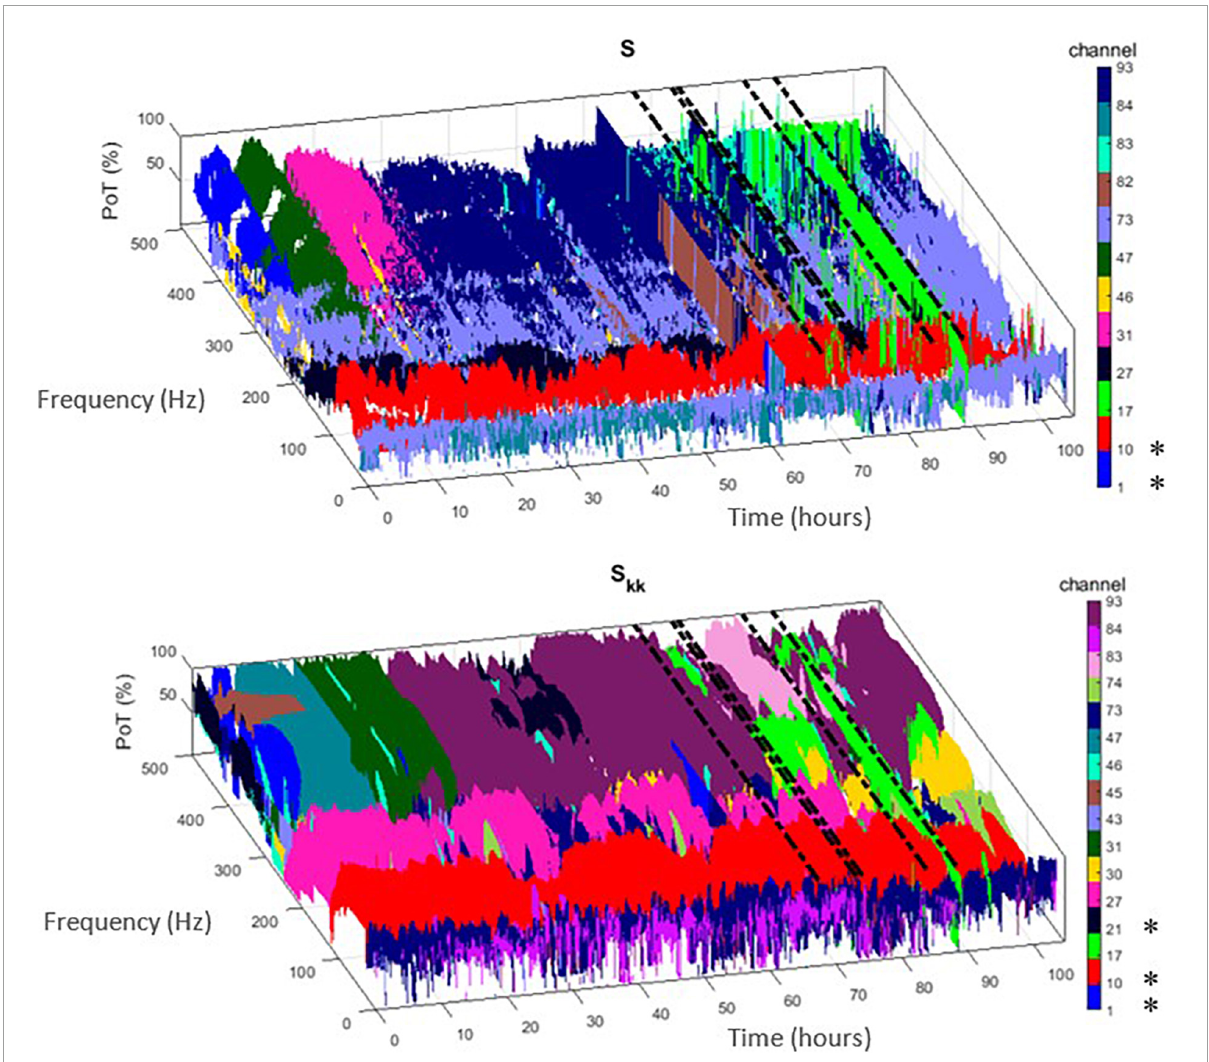
FIGURE1 Time-frequency plots of the highest percentage of time (PoT) channels that exhibited maximum power within the non-overlapping 10 min window from the two proposed measures [i.e., periodogram ( S ) – (top) and auto-spectra ( S kk ) – (bottom) ]. Each channel is denoted with a different color. If this methodology selected clinically assessed focal channels for patient PT103, we denote them by ( ∗ ) in the colorbar. Dashed black lines indicate the timing of the